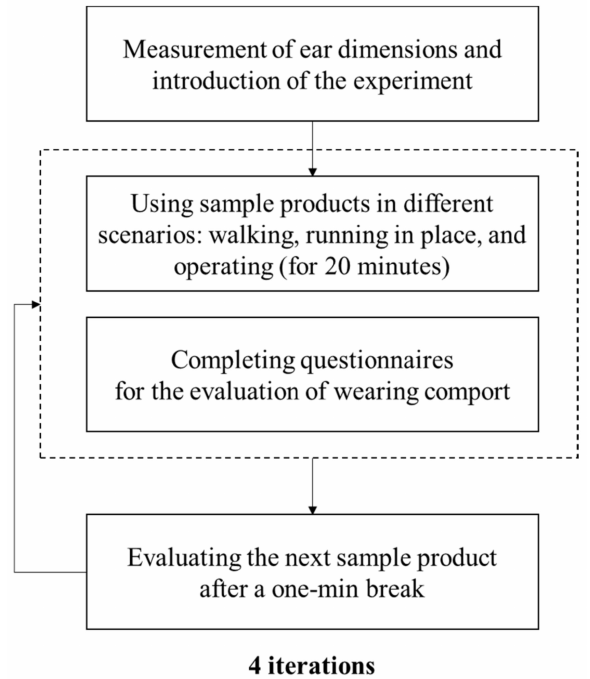
Figure 3. The evaluation process of the wearing comfort for wireless